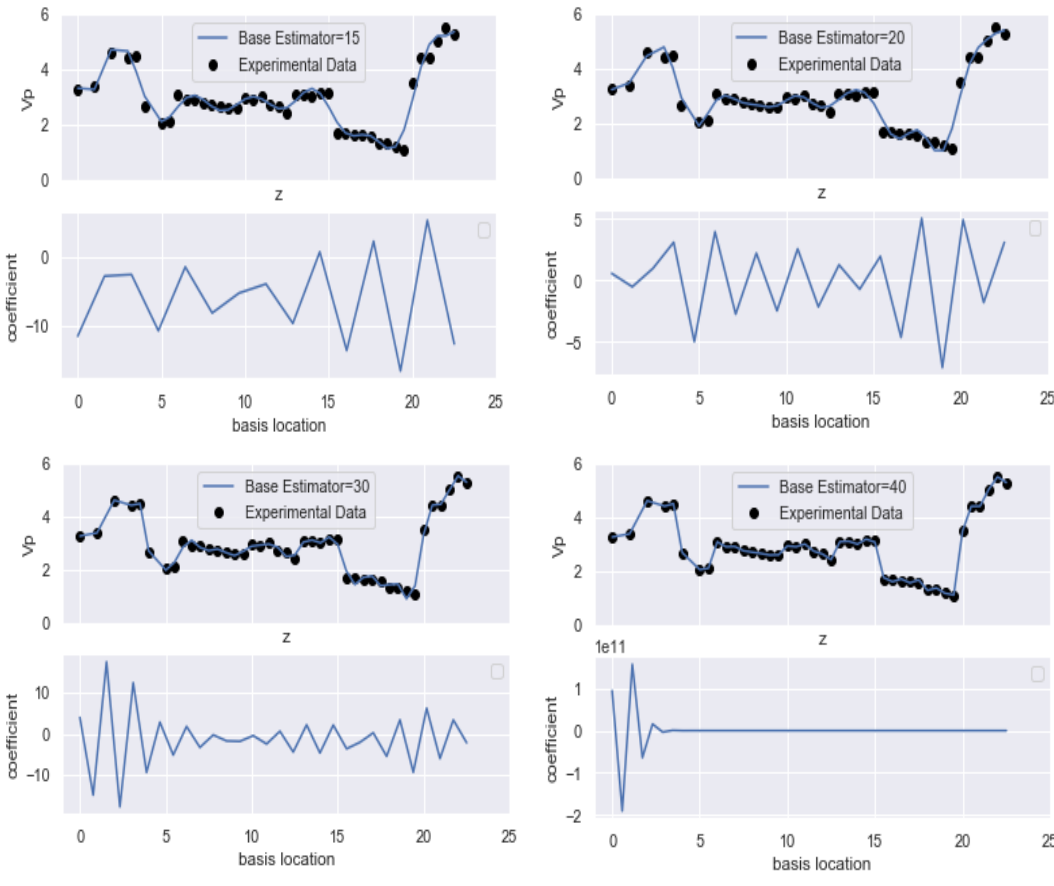
Figure 6. The coefficients of adjacent Gaussian basis functions (of Base Estimator = 15, 20, 30, 40) for the prediction